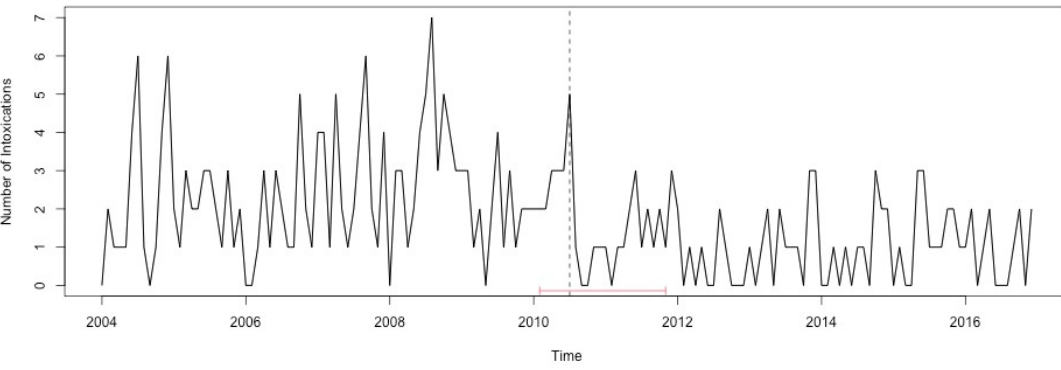
Figure A52. Heroin intoxications 2004–2016 in the Czech Republic and structural breaks.